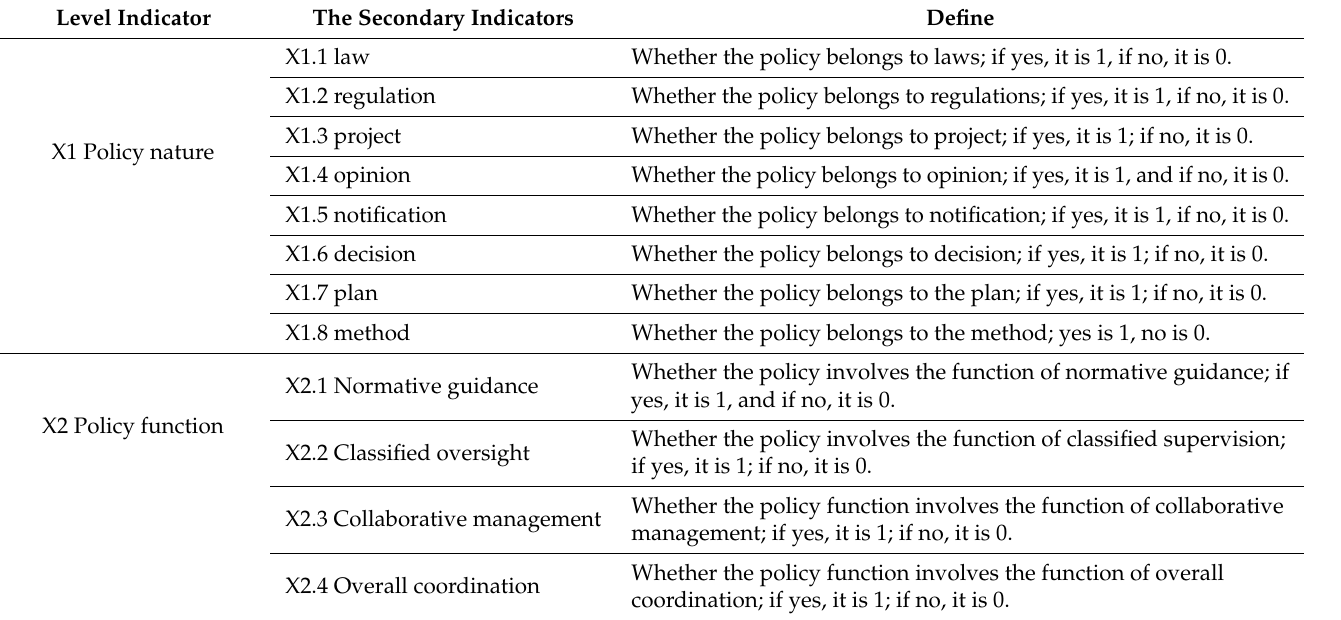
Figure 1. Keyword Network Map. Table 3. PMC evaluation index system and evaluation